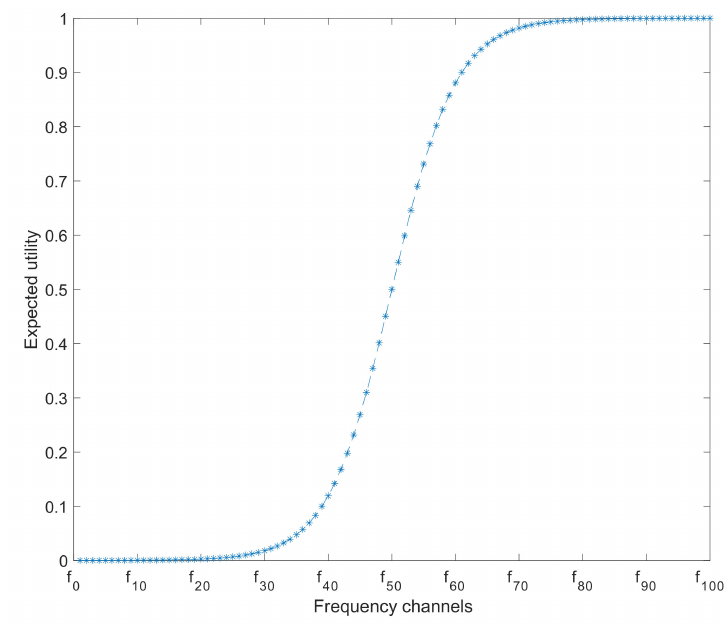
Figure 2. Expected utility of the frequency